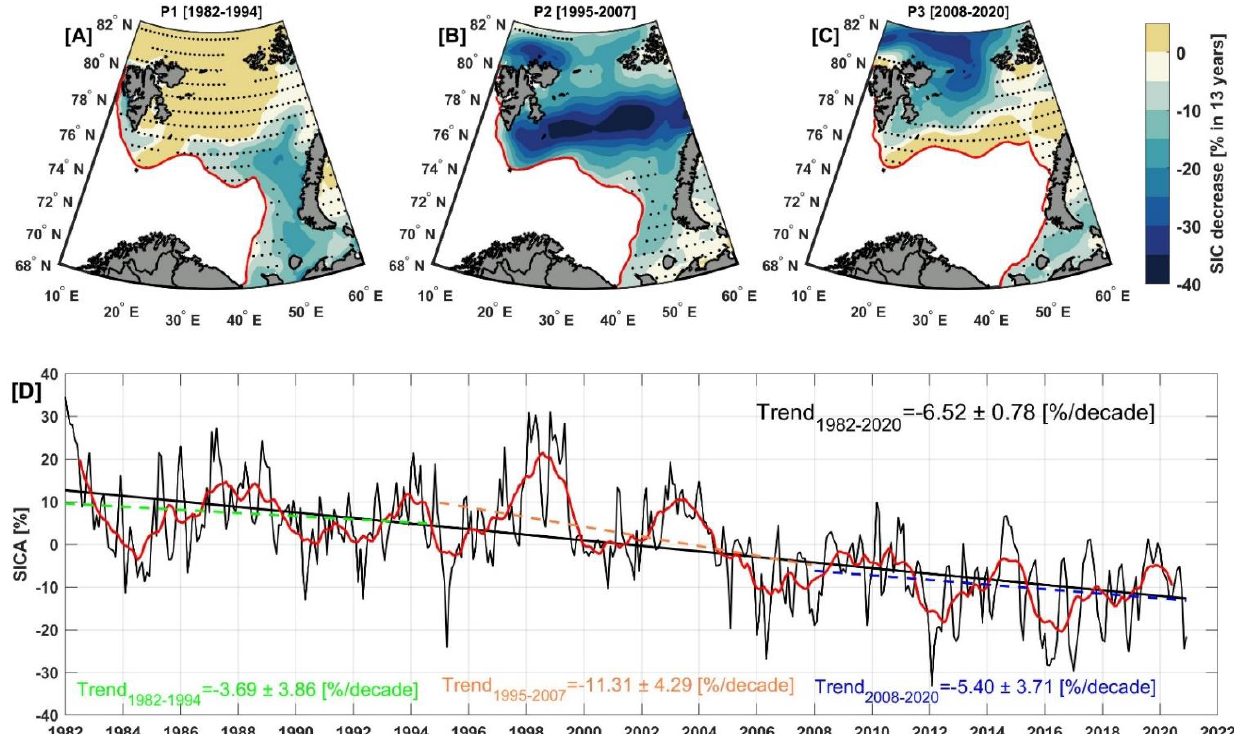
Figure 10. Spatial distribution of the de-seasoned trends of SICA for the periods; ( A ) P1 (1982 – 1994), ( B ) P2 (1995 – 2007), and ( C ) P3 (2008 – 2020), respectively. Regions where the trends are not statistically significant at the 95% confidence interval (after Mann –Kendall’s test) are stippled. The red lines represent the mean April sea-ice edge (15% SIC) for each period. ( D ) De-seasoned monthly mean time series of spatially averaged SICA over the ice-covered zone from 1982 through 2020. Trends for each period (colored dashed lines) and for the entire period (black solid line) are also shown. To enhance the visualization and to emphasize interannual variability, the data was low passed using a 13-month moving average (red line).